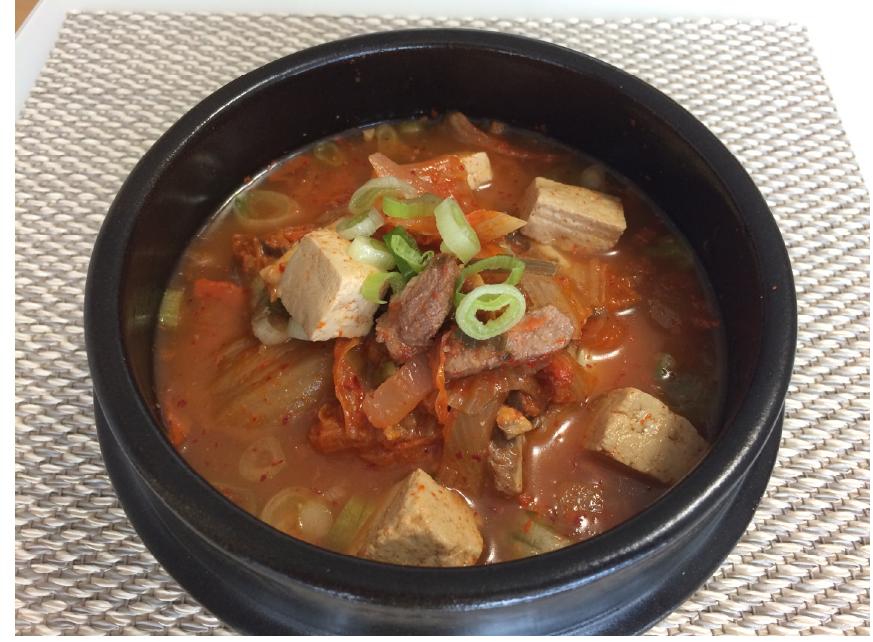
Figure A8. Ingredients: matured kimchi, pork, tofu, spring onion, oil, red chili powder, garlic; see recipe at: http://www.maangchi.com/recipe/kimchi ‐ jjigae.